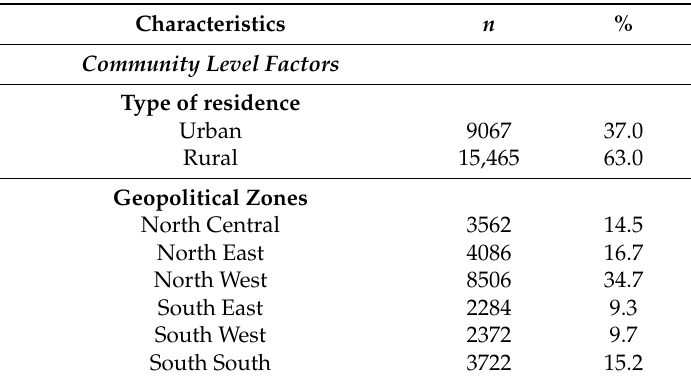
Table 1. Characteristics of independent variables.